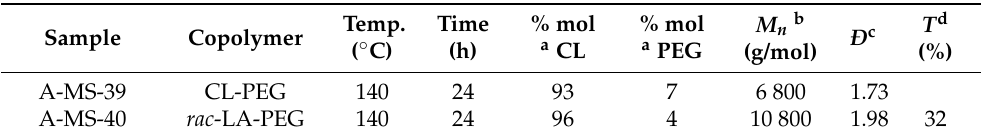
Table 3. Synthesis of ε -caprolactone-poly(ethylene glycol) (CL-PEG) and rac-LA-PEG copolymers in a larger scale.